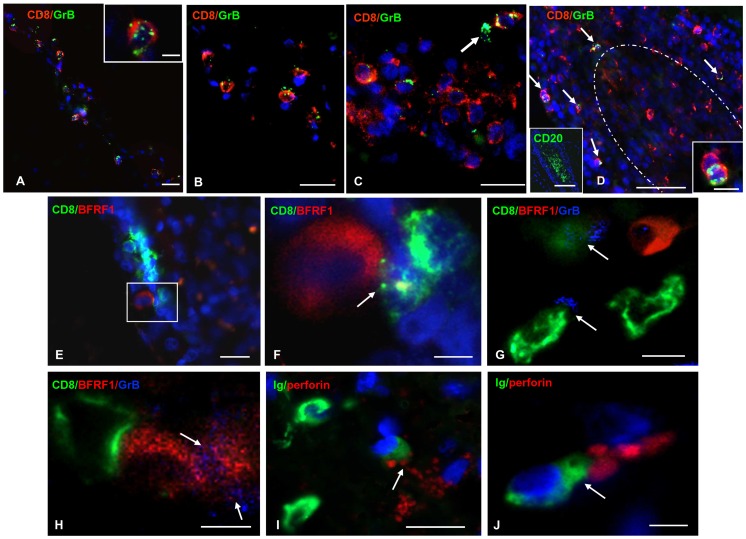
Cytotoxic attack on EBV infected cells in the MS brain.(A, B) Double immunofluorescence stainings for granzyme B (GrB, green) and CD8 (red) performed on sections of highly inflamed MS brain samples show granzyme B expression in a substantial proportion of CD8+ T cells present in two perivascular inflammatory cell infiltrates of an active white matter lesion; granzyme B-containing granules are localized in the cytoplasm and on the surface of CD8+ cells (inset in A). (C) Presence of granzyme+ CD8+ cells in a diffuse meningeal immune infiltrate. The arrow points to one of the rare granzyme B+/CD8− cells. (D) Double immunofluorescence staining for CD8 (red) and granzyme B (green) shows that granzyme B−/CD8+ cells accumulate outside and inside a B-cell follicle (marked with a dotted line and stained for CD20 in the left inset), whereas double labelled granzyme B+/CD8+ cells are detectable only at the periphery the B-cell rich area (arrows). Two CD8+ cells, one of which is also granzyme B+, are shown at high power magnification in the inset on the right. (E) Group of CD8+ cells (green) close to an EBV lytically infected, BFRF-1+ cell (red) at the border of a B-cell follicle. (F) The CD8+ cell closer to the BRFR-1+ cell extends cytoplasmic processes (arrow) that adhere to the infected cell (high magnification of the area marked with the frame in E). (G) Three CD8+ cells (green) with a lymphobast-like morphology are close to, but do not touch, a BFRF-1+ cell (red) in the inflamed meninges; two of the CD8+ cells display granzyme B-containing granules on their surface (blue, arrows). (H) Two BFRF-1+ cells (red), one of which is enclosed by a CD8+ cell (green) and both are covered by granzyme B+ granules (blue, arrows) at the border of a meningeal B-cell follicle. (I, J) Double immunofluorescence stainings for perforin (red) and Ig (green) show perforin granules polarized toward Ig+ plasma cells (arrows) in active white matter lesions. Nuclei are stained with DAPI (blue) (A, B, C, D, E, F, I, J). Bars : 100 µm in the left inset in D; 50 µm in D; 20 µm in A–C, E, I; 10 µm in G, H and right inset in D; 5 µm in F, J and inset in A.